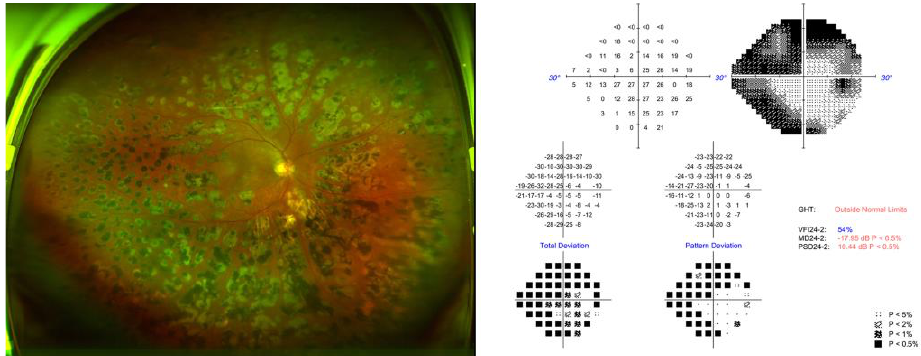
Figure 1. Preoperative ultra-wide-field fundus photograph and visual field. (GHT, glaucoma hemifield test; MD, mean deviation; PSD, pattern standard deviation).